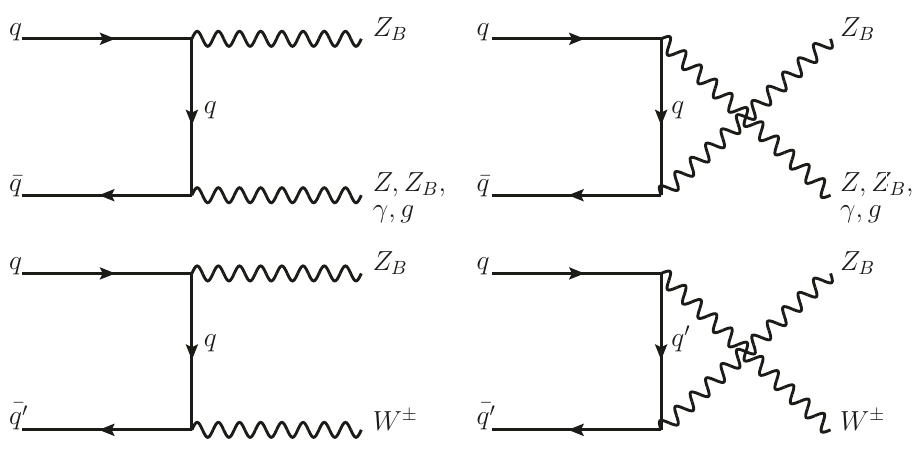
Figure 12 . Di-boson production